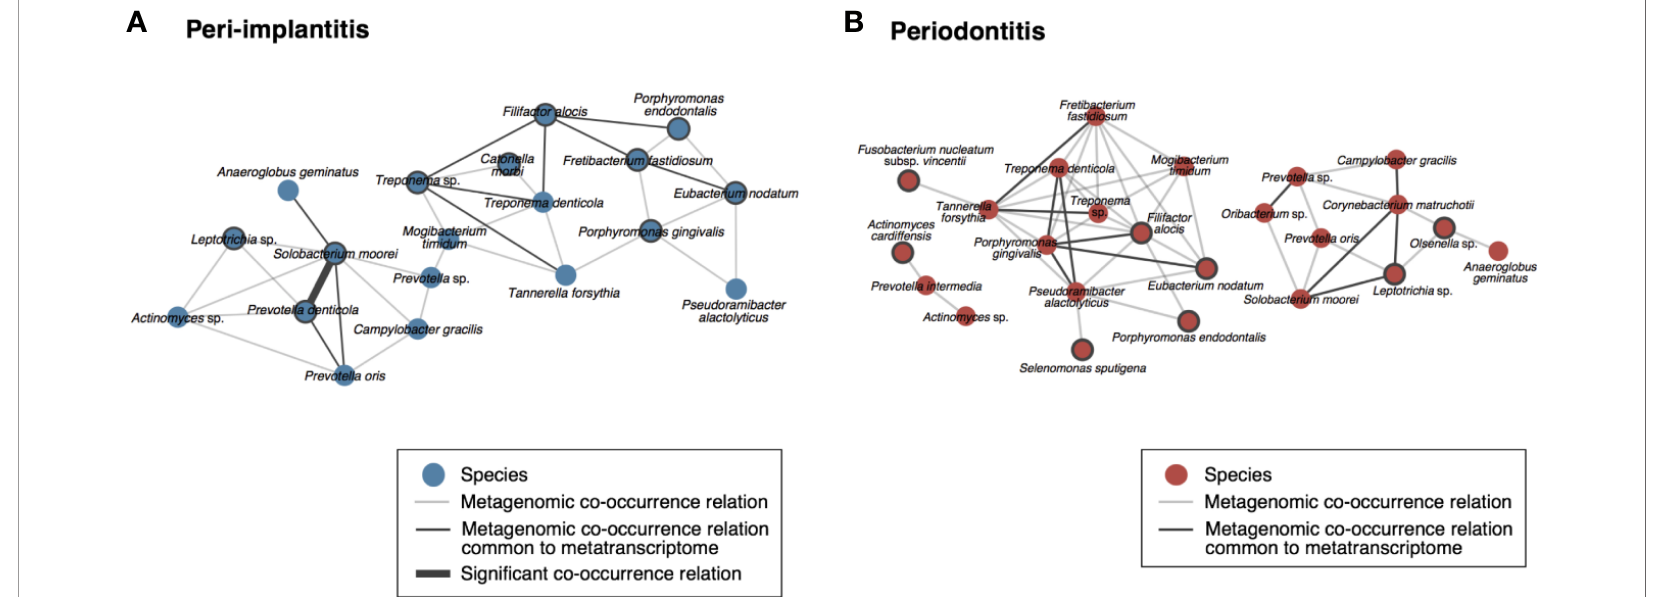
FIGURE 4 | Co-occurrence networks based on species taxa common to metagenomic and metatranscriptomic analyses in (A) peri-implantitis and (B) periodontitis. All metagenomic interactions are shown by a gray line and metatranscriptomic interactions common to the metagenome are indicated by a black line. Active taxa (RNA/DNA ratio >3) are indicated by bold circles, and interactions with signi fi cant co-occurrence are indicated by bold black